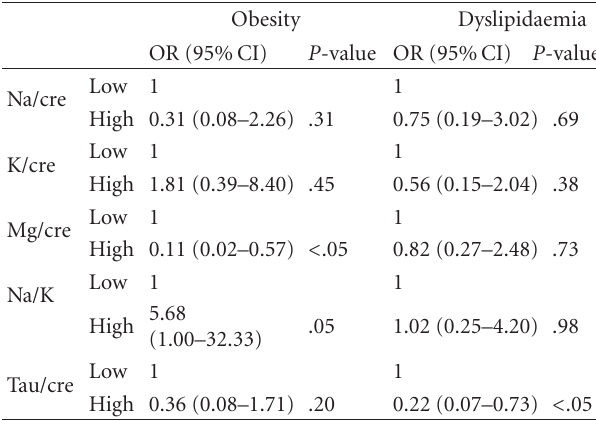
Table 3: Adjusted odds ratios of obesity and dyslipidaemia according to urinary biomarkers.